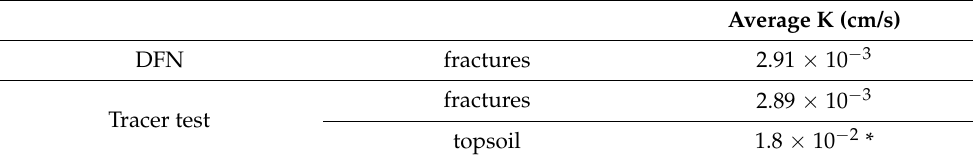
Table 4. Results of conductivity (K) derived from the DFN model and tracer tests for the topsoil and